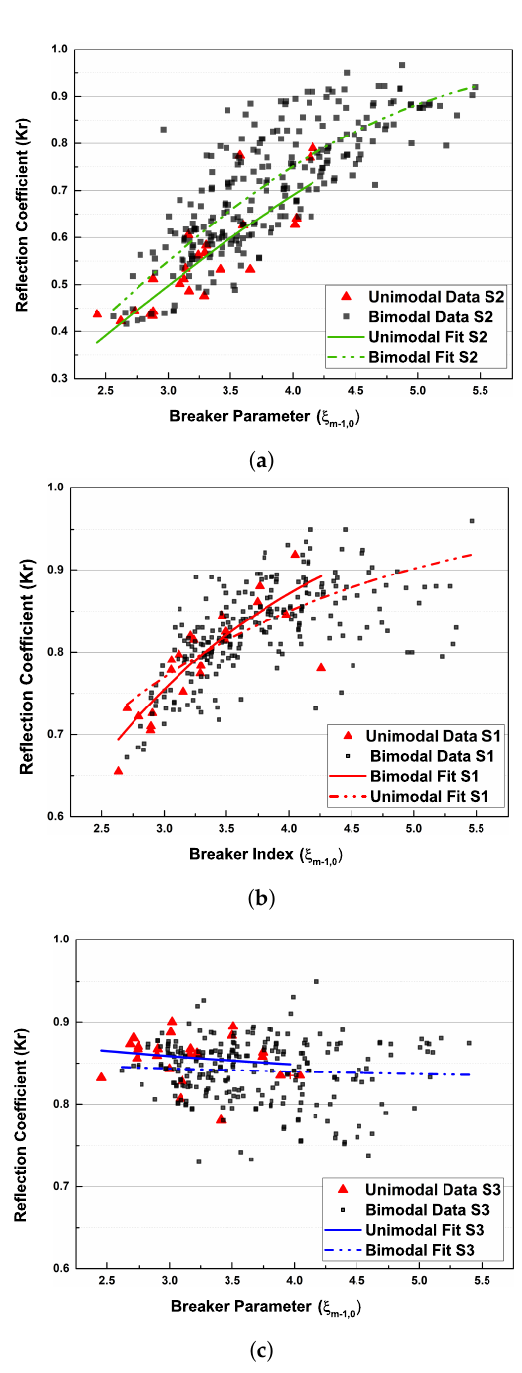
Figure 4. Comparison of the reflection coefficient K r and breaker parameters ξ m − 1,0 between unimodal and bimodal seas across three slopes for: ( a ) cot α = 3.0, ( b ) cot α = 1.5, and ( c ) cot α =